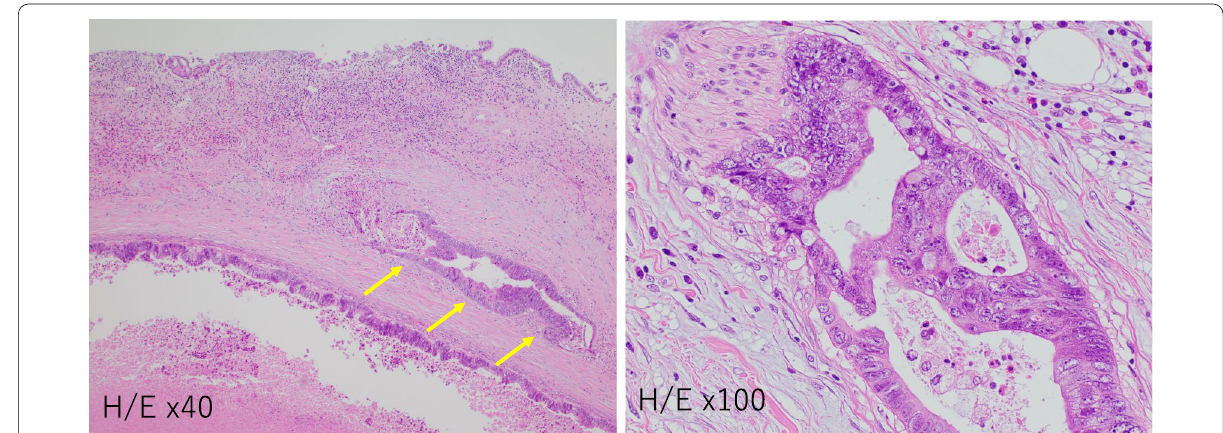
Fig. 2 Microscopic findings of colon cancer metastasis mimicking hilar cholangiocarcinoma. Their arrows indicate perineural infiltration